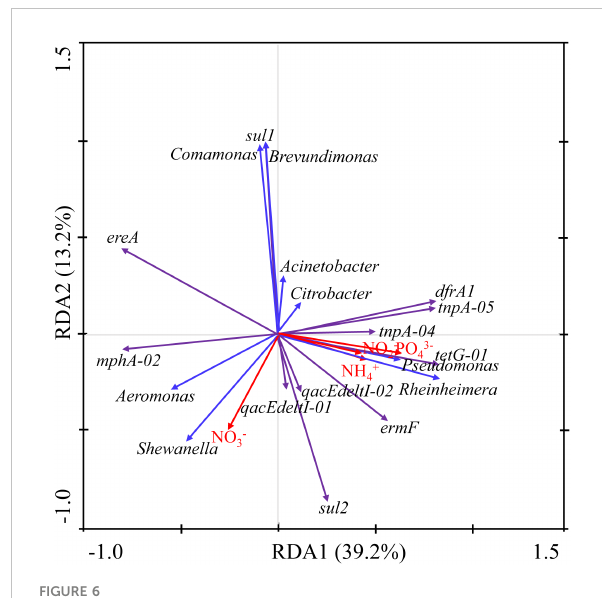
FIGURE 6 Redundancy analysis of ARGs, ARB, and water